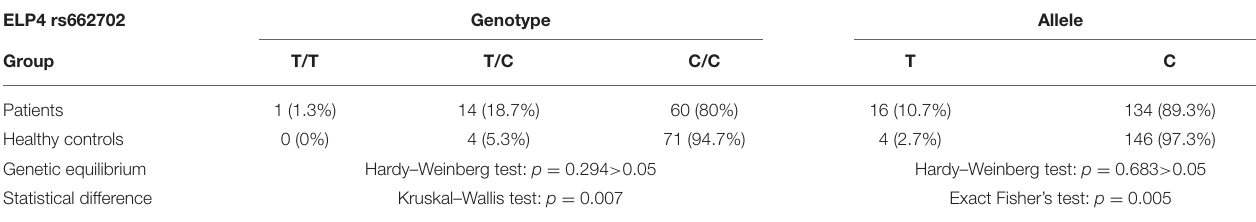
TABLE 1 | ELP4 RS662702 genotypes, allele distribution, and genetic